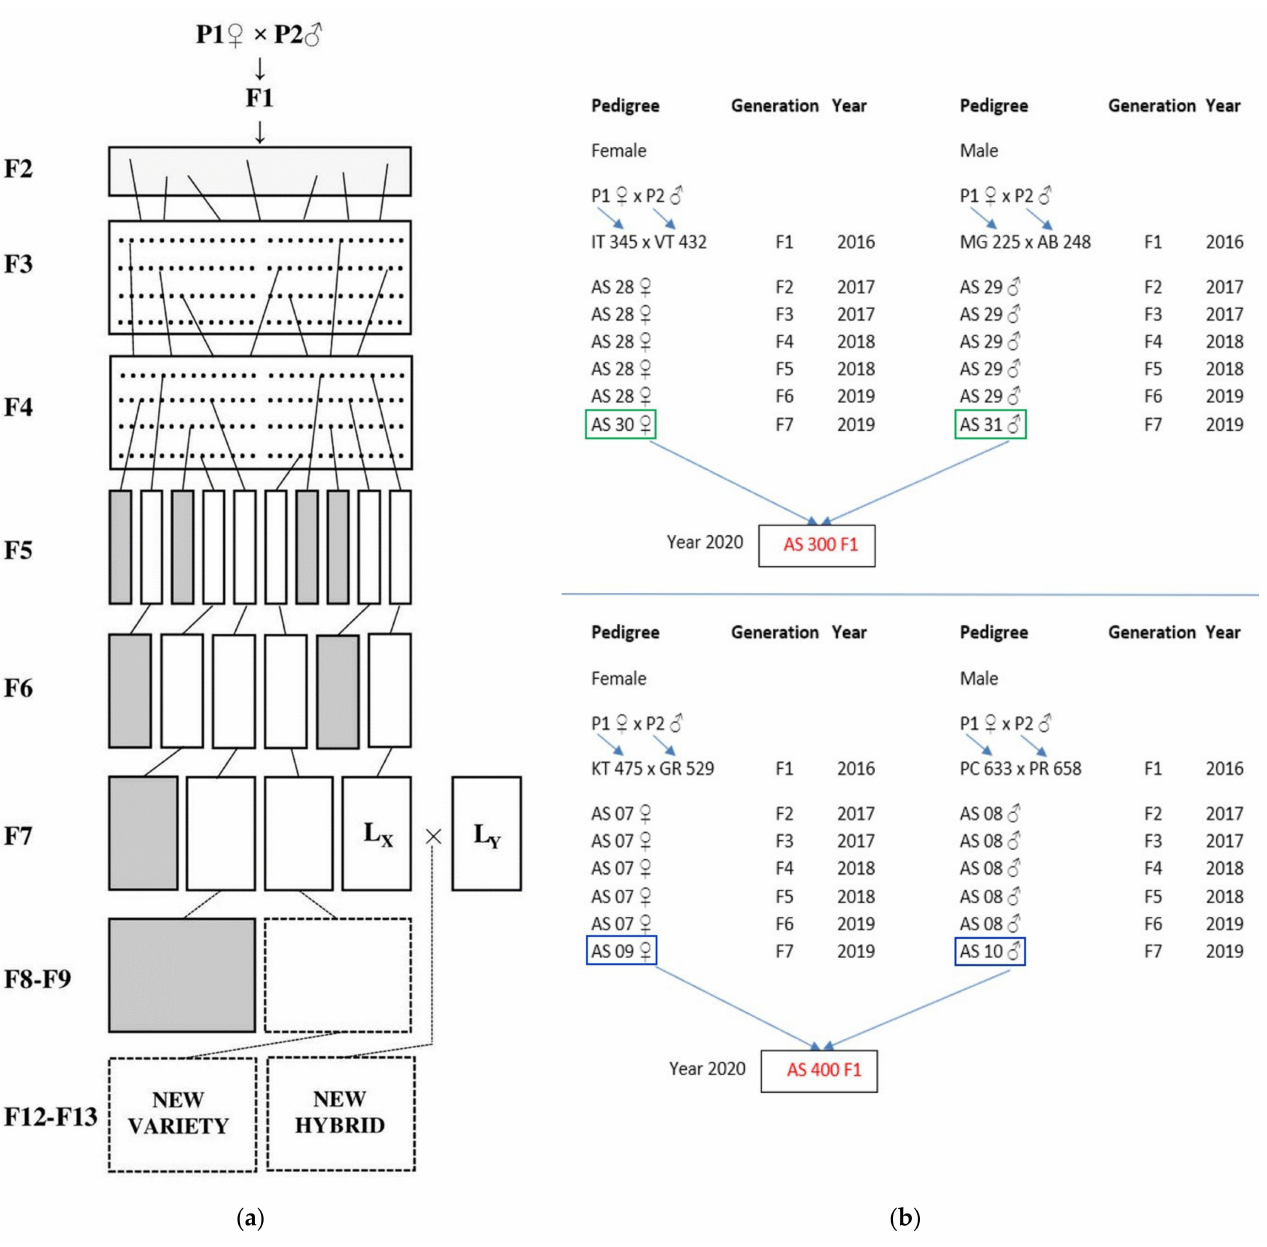
Figure 7. ( a ) ‘Classic’ scheme—pedigree selection, widely used to obtain new tomato varieties. The scheme can also be used for the selection of new lines, which after testing GCA and SCA values can be used as parental forms for obtaining commercial hybrids; ( b ) Scheme for obtaining the two newly commercial hybrids used in experiment: AS 300 F1, and its parental, maternal and paternal lines AS 30 (F7) and AS 31 (F7); AS 400 F1 and its parental, maternal and paternal lines, ♀ ♂ AS 09 (F7) and AS 10 (F7). The parental lines were obtained based on the scheme of Figure 7a, up to F7 ♀ ♂